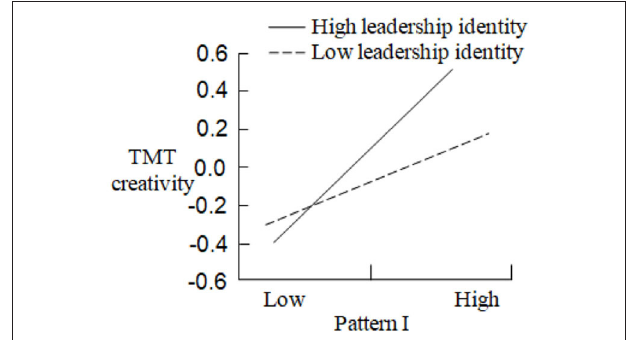
FIGURE 3 | The moderating effect of leadership identity in the relationship between pattern I and TMT creativity.